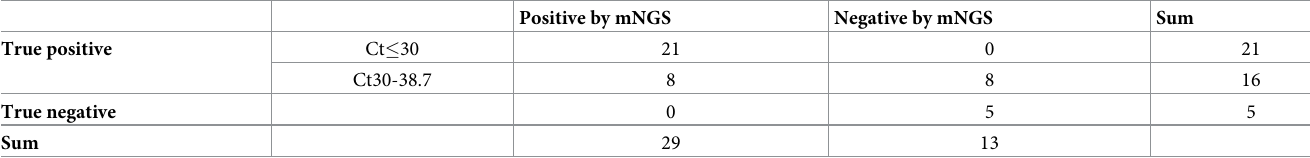
Table 2. Overall sample classification, before adjustment for barcode crosstalk.